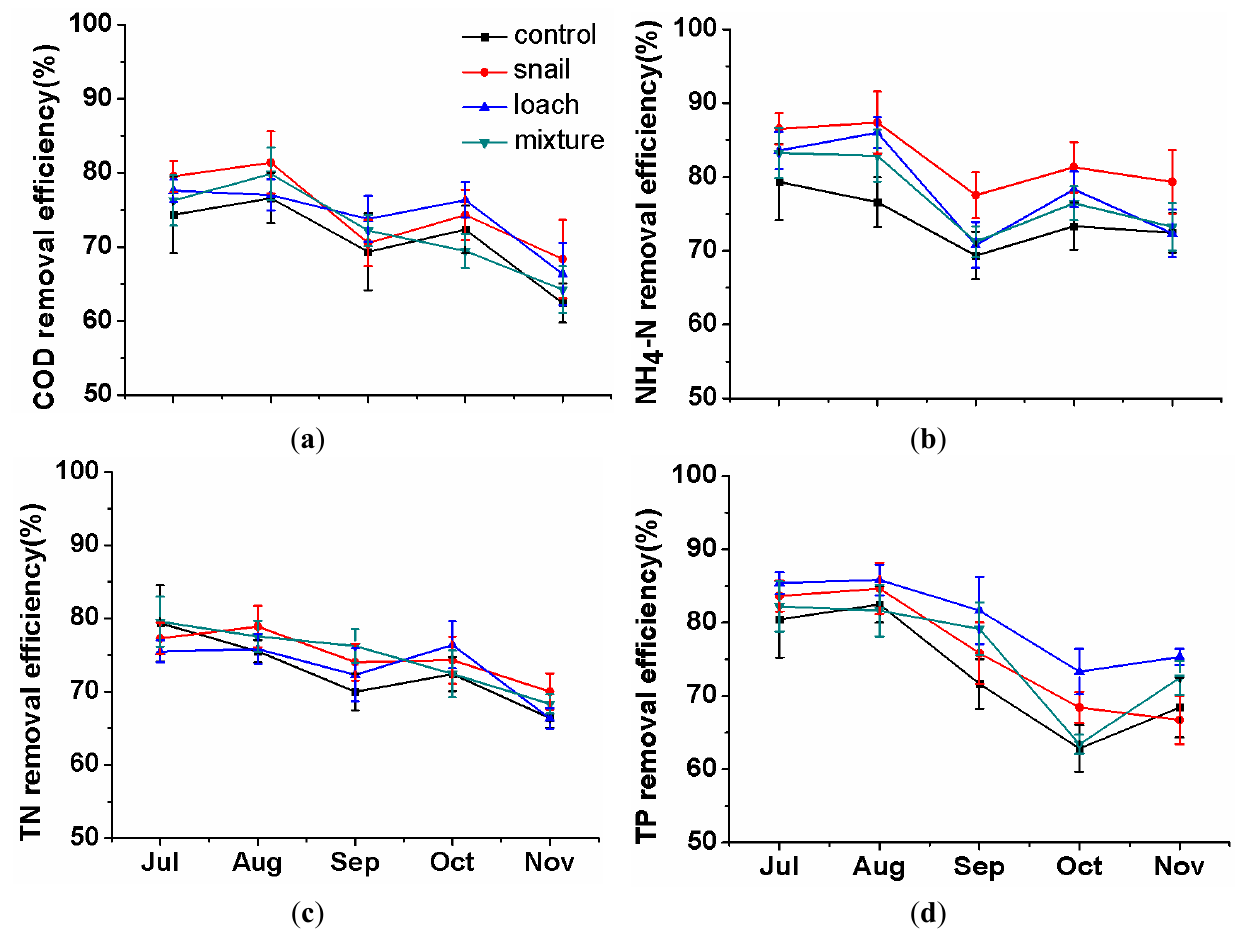
Figure 2. Removal efficiency of COD ( a ); NH 4 -N ( b ); TN ( c ); TP ( d